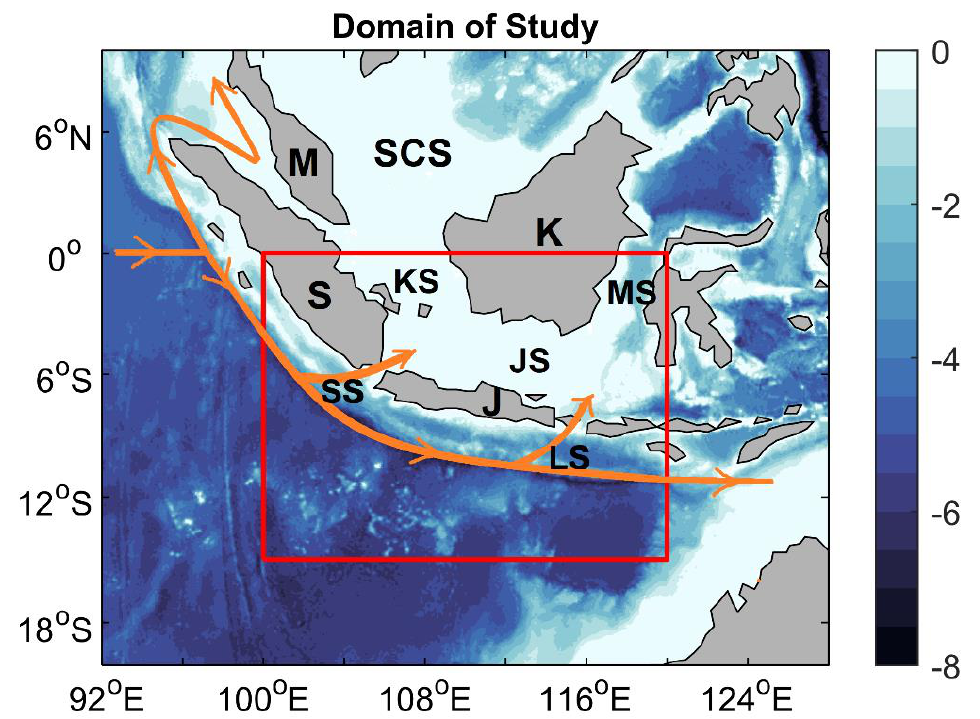
Figure 1. The shaded background represents bottom bathymetry (in km) from the ETOPO2 dataset along the south-eastern Indian Ocean consisting of the Maritime Continents. The red box represents the domain of interest. The maritime continents, as well as the straits, are denoted as Malaysia (M), Sumatra (S), Kalimantan (K), Java (J), Karimata Strait (KS), Makassar Strait (MS), Sunda Strait (SS), Java Sea (JS), Lombok Strait (LS) and SCS (South China Sea). The orange track shows the propagation of coastal Kelvin waves, south Java coastal current and circulation pattern along the Sumatra and Java coast during the northwest monsoon [22].